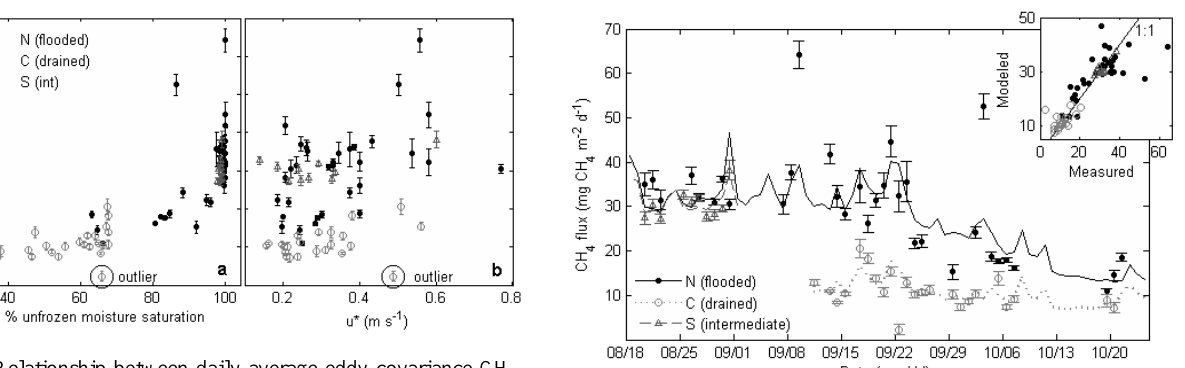
Figure 6. Relationship between daily average eddy covariance CH 4 flux and unfrozen 2 Fig. 6. Relationship between daily average eddy covariance CH 4 moisture saturation in the top 30 cm of soil (a), and the relationship between eddy covariance 3 flux and unfrozen moisture saturation in the top 30cm of soil (a) , and the relationship between eddy covariance CH 4 flux and friction CH 4 flux and friction velocity (b). The circled point was an outlier removed from the 4 velocity (b) . The circled point was an outlier removed from the correlation analysis. Error bars represent standard error of the mean. 5 correlation analysis. Error bars represent standard error of the mean.